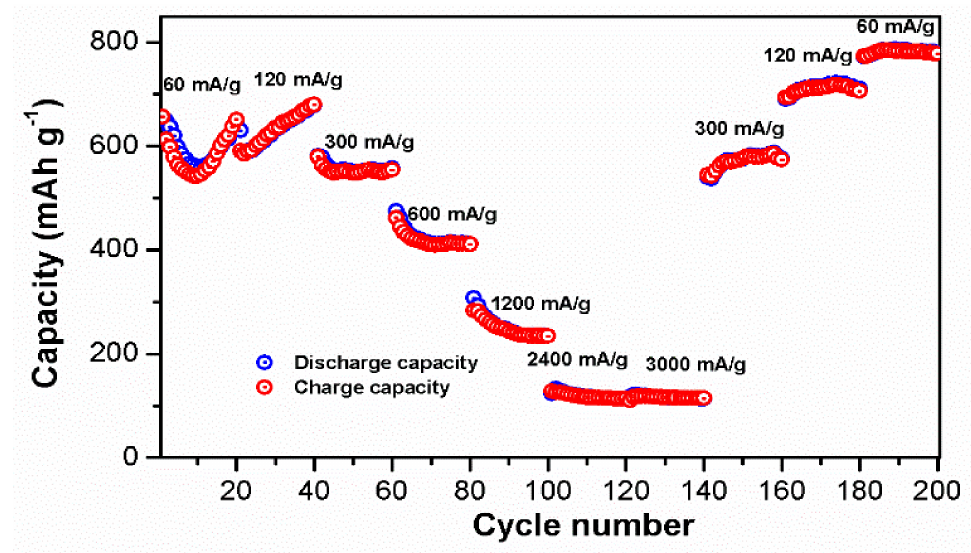
Figure 4. Rate capability studies of G-Nifum composite at different current densities such as 60, 120, 300, 600, 1200, 2400, and 3600 mA g − 1